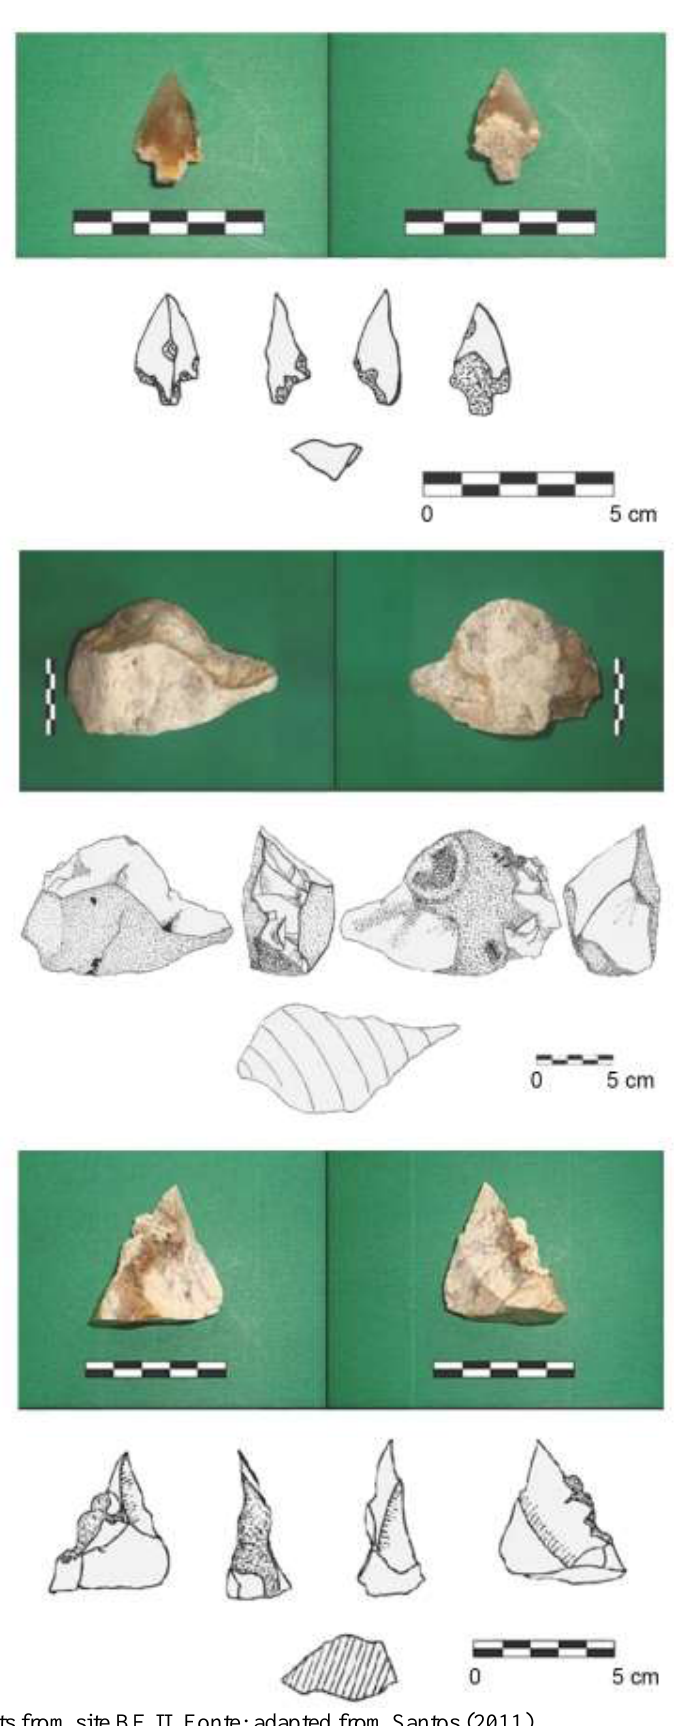
Figure 9. Chert artifacts from site BE II. Fonte: adapted from Santos